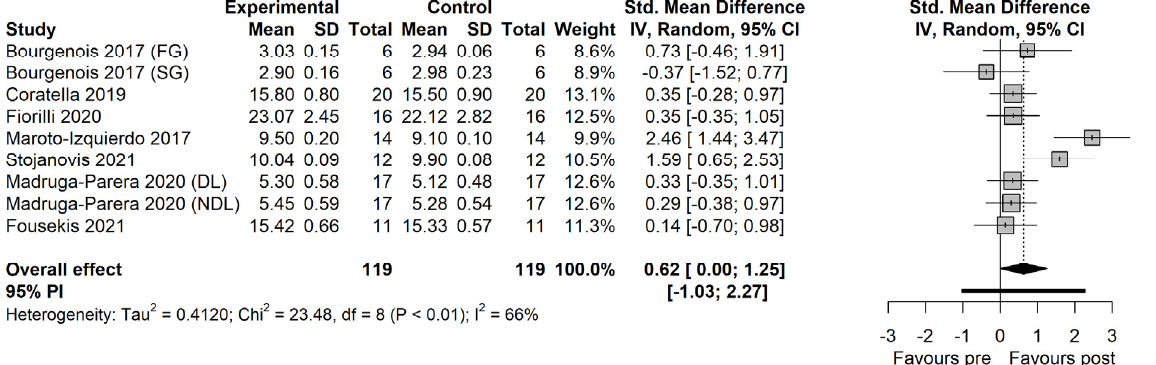
Figure 5. The effects of traditional resistance training on change of direction performance in male athletes [22–28]. FG: fast group; SG: slow group; DL: dominant leg; NDL: non-dominant leg; RL: right leg. 3.4. Single Training Factor Analyses For FRT, no signi fi cant e ff ects for 8 weeks (SMD = 1.15 [ − 0.50 to 2.82]; p > 0.05) and 6 weeks (SMD = 2.05 [ − 0.61 to 4.71]; p > 0.05) of training were observed. In terms of training frequency, ≤ 2 sessions/week resulted in significant large effects (SMD = 1.33 [0.32 to 2.35]; p < 0.05), whereas no signi fi cant e ff ects of > 2 sessions/week were noted (SMD = 2.35 [ − 5.04 to 9.74]; p > 0.05). Regarding the total number of training sessions, the results indicated significant large effects of ≤ 12 (SMD = 1.83 [0.60 to 3.06]; p < 0.05), with no significant e ff ects of > 12 (SMD = 1.52 [ − 1.36 to 4.39]; p > 0.05) sessions. No significant differences between all single training factors were detected ( p > 0.05) (Table 4).